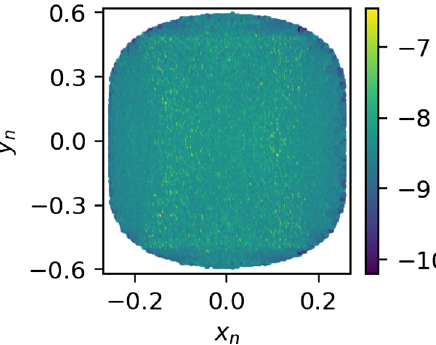
FIG. 19. Beam density at the 0-th turn (left), 128-th turn (middle) and 256-th turn (right).